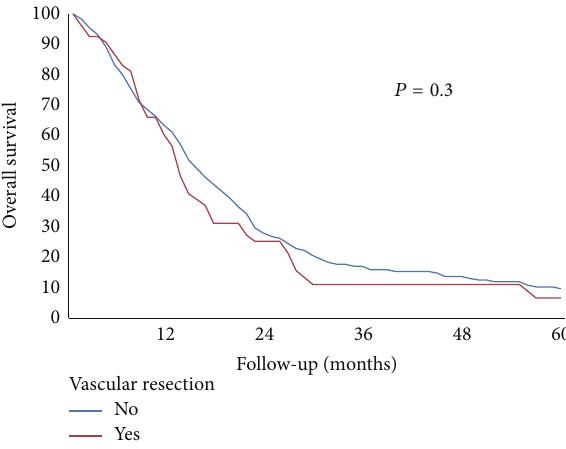
Figure 1: Overall survival in patients who underwent pancreatic resection with or without vascular resection.